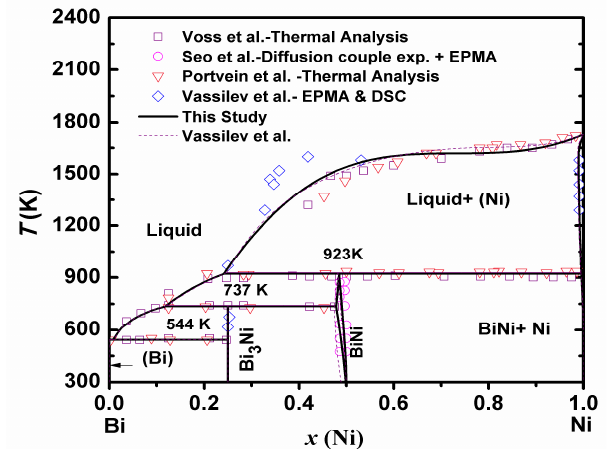
Figure 3. Calculated phase diagram of Bi-Ni system with experimental phase diagram data point from the literature (Vassilev et al. [43], Voss et al. [44], Seo et al. [45], Portvein et al. [46]).